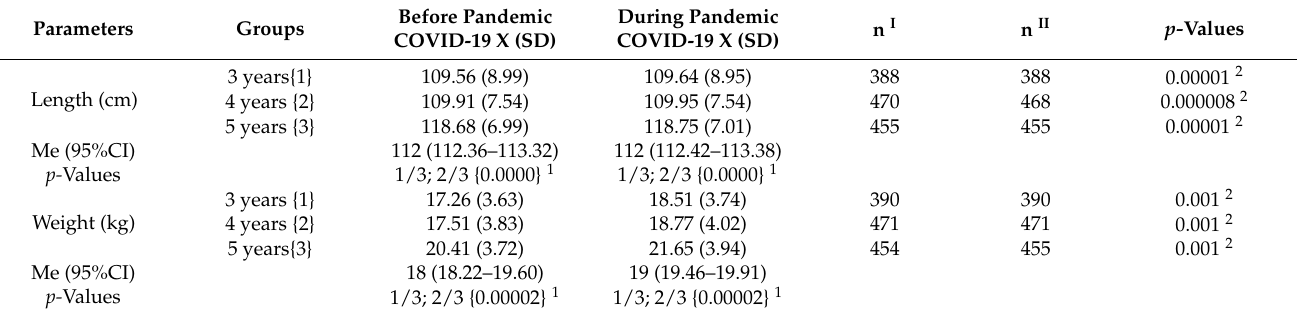
Table 1. Participants’ general characteristics and